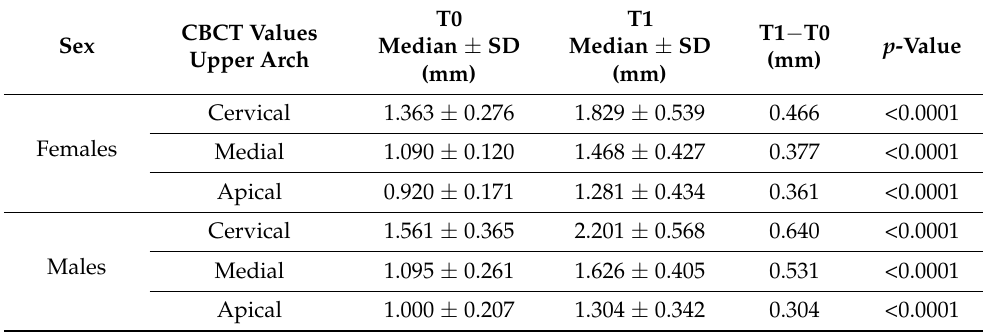
Table 1. Comparison of the level of buccal bone thickness at T0 and T1 in both sexes in the maxillary group, based on Cone Beam Computer Tomography values.